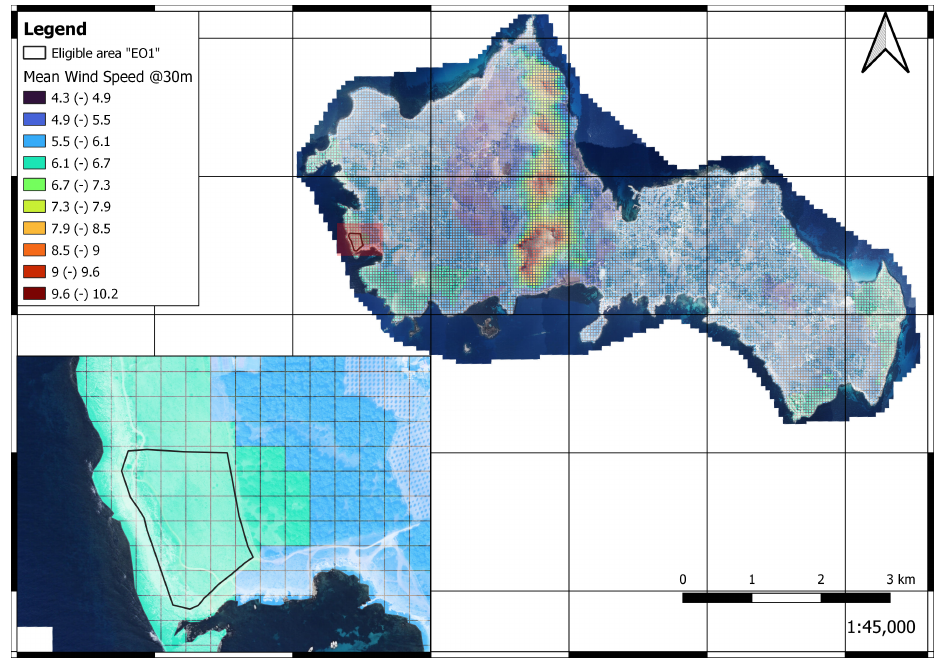
Figure 26. Favignana eligible area and mean wind speed.